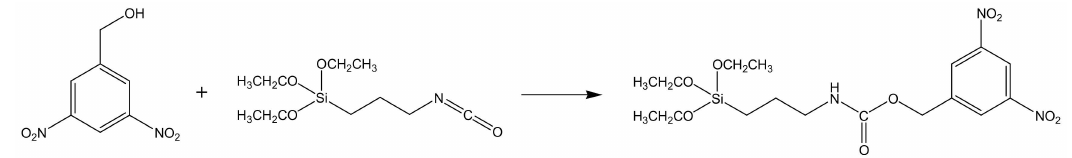
Figure 4. Scheme of template